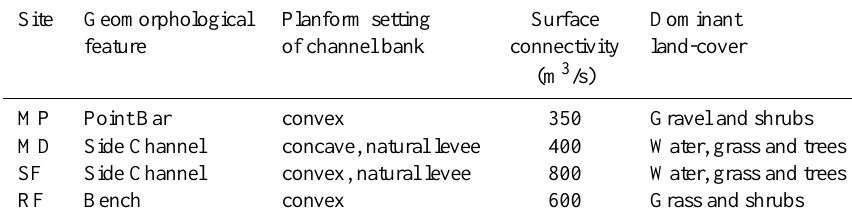
tivity – Fig. 1, Table 1: Mejana de Pastriz (MP) and